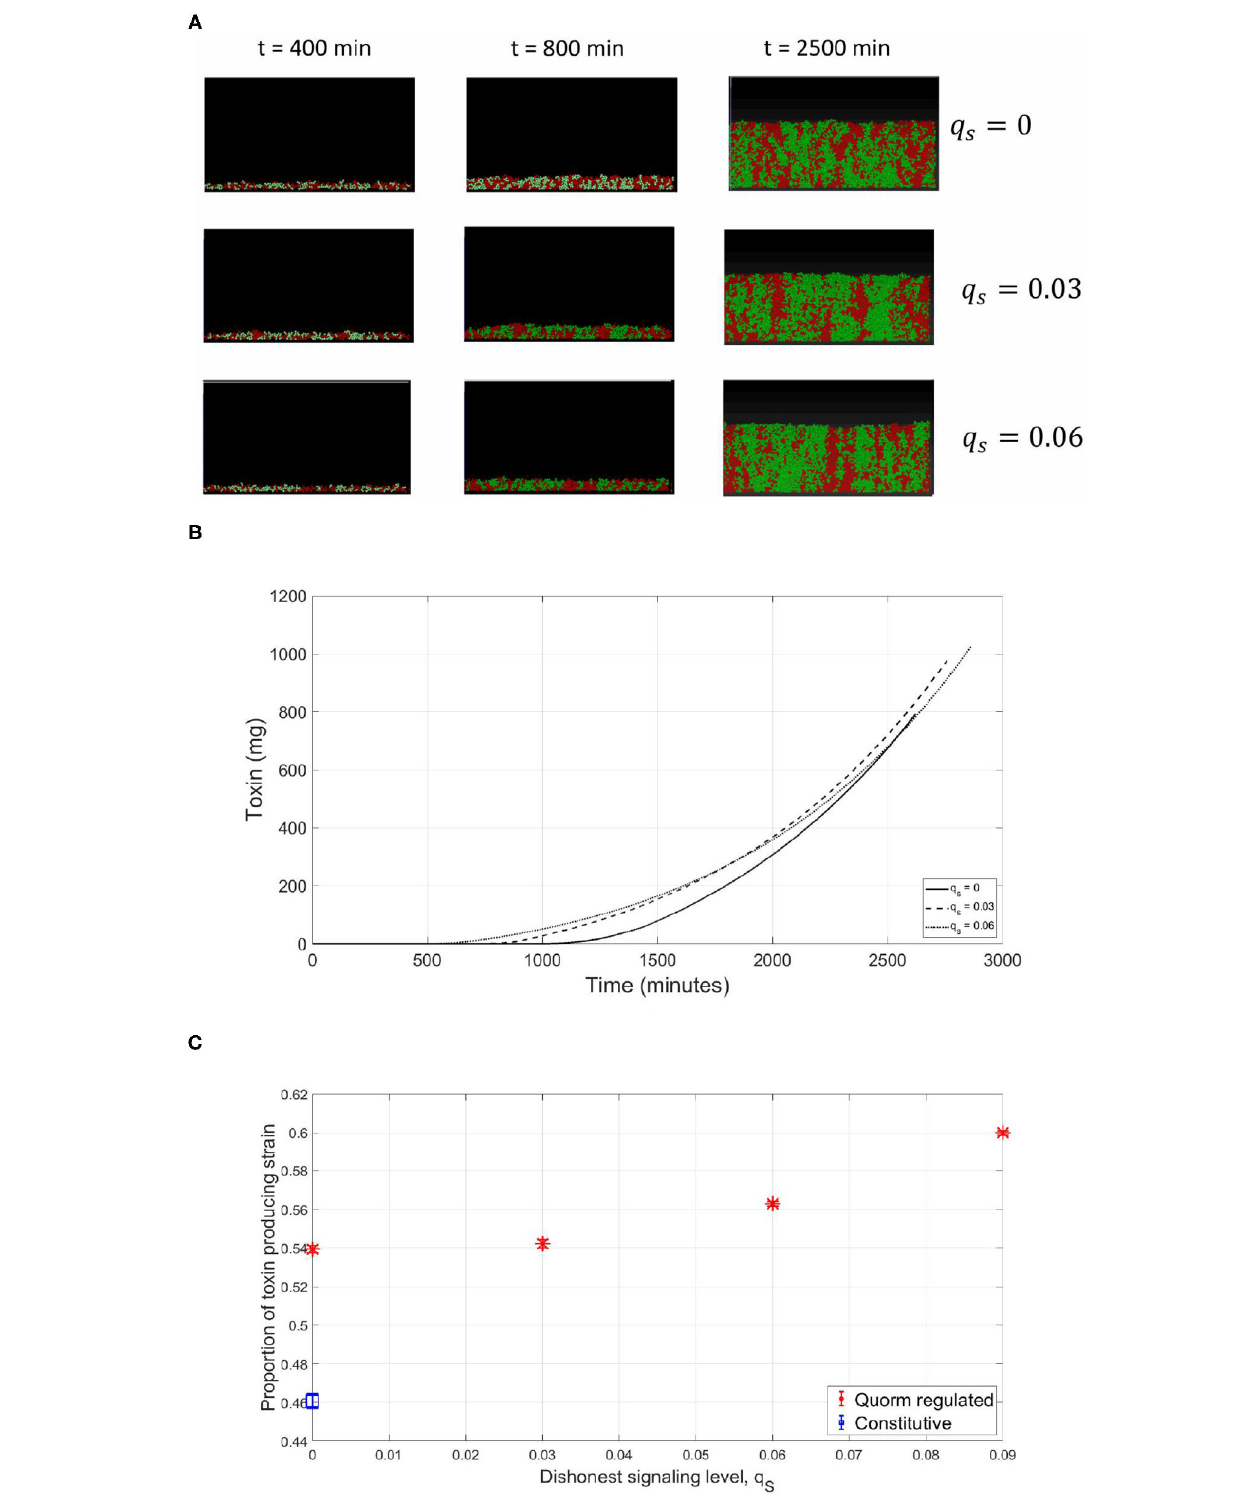
FIGURE 9 | Spatial competition, expensive signaling (higher than LERS). As observed in the well-mixed scenario, while the production of dishonest signals can lead to the premature expression of toxin by the focal toxin producer, the cost of this strategy becomes too high for the dishonest signals producing sensitive strain. (A) An individual-based model for a competition between a focal QS toxin producer (green) and a sensitive strain (red), under different dishonest signaling levels from the sensitive strain. (B) The total quantity of toxin produced as a function of time in the simulations. (C) The proportion of the focal toxin producing strain at the end of the experiments under different levels of dishonest